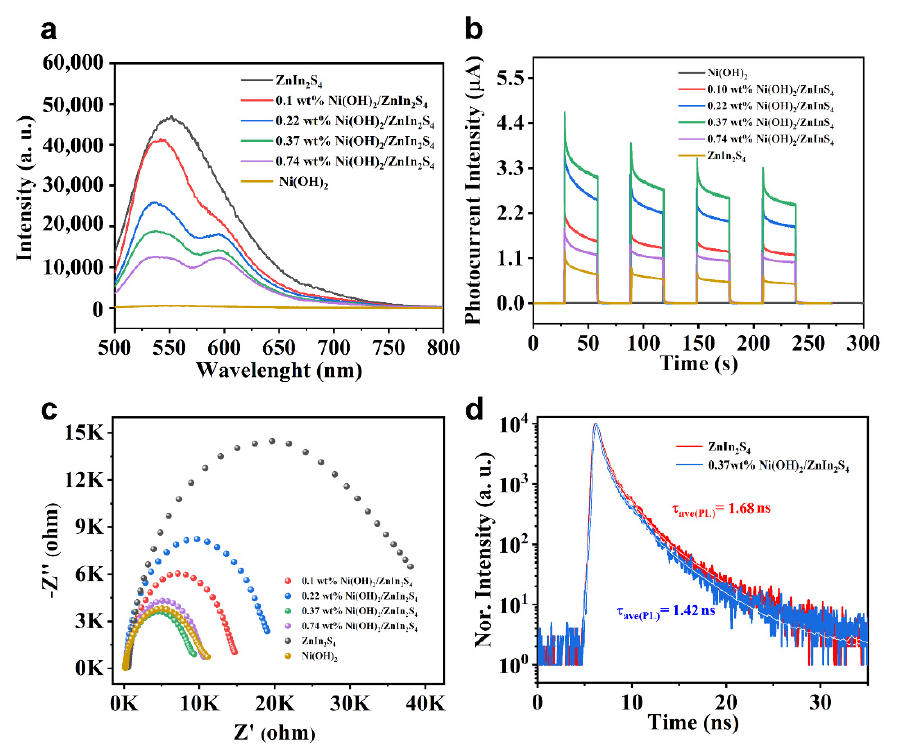
Figure 5. PL spectra ( a ) and transient photocurrent responses ( b ) of pure ZnIn 2 S 4 , Ni(OH) 2 , and Ni(OH) 2 /ZnIn 2 S 4 composite samples with different amounts of Ni(OH) 2 involved. EIS ( c ) of different samples. PL lifetime decay curves ( d ) of ZnIn 2 S 4 (red) and 0.37 wt% Ni(OH) 2 /ZnIn 2 S 4 (blue), respectively.